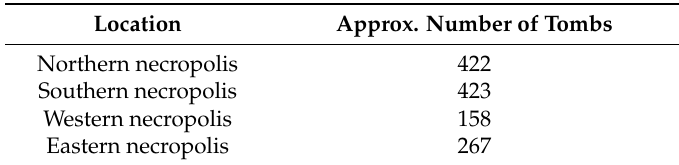
Table 4. Cemeteries of Cyrene. Details from Cassels’ notebooks